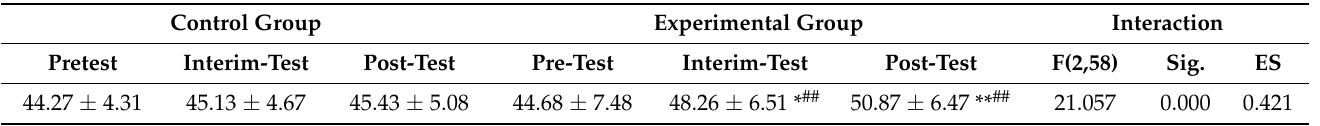
Table 4. Comparison of social skills across three intervals between groups.